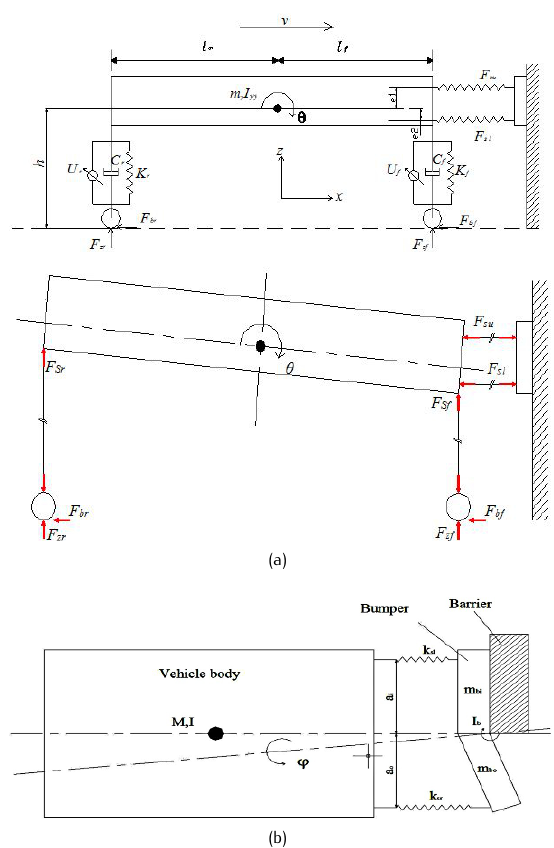
Figure 2. (a) pitch-plane view and its free-body diagram; (b) yaw- plane view and its free-body diagram.